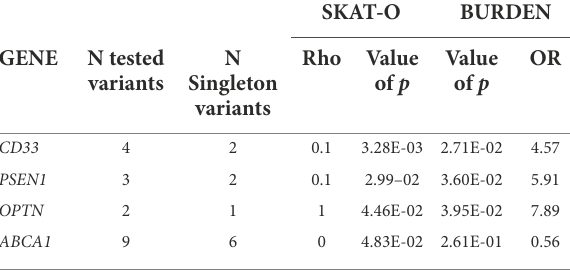
rtv = right temporal variant; sv = semantic variant; na = not available; CSF = cerebrospinal fluid; PET = positron emission tomography; MMSE = Mini-Mental State Examination; MoCA = Montreal Cognitive Assessment; FAB = Frontal Assessment Battery; FBI = Frontal Behavioral Inventory.*under cut-off; pos = positive; neg = negative. For MAPT , reference NM_005910 is used.